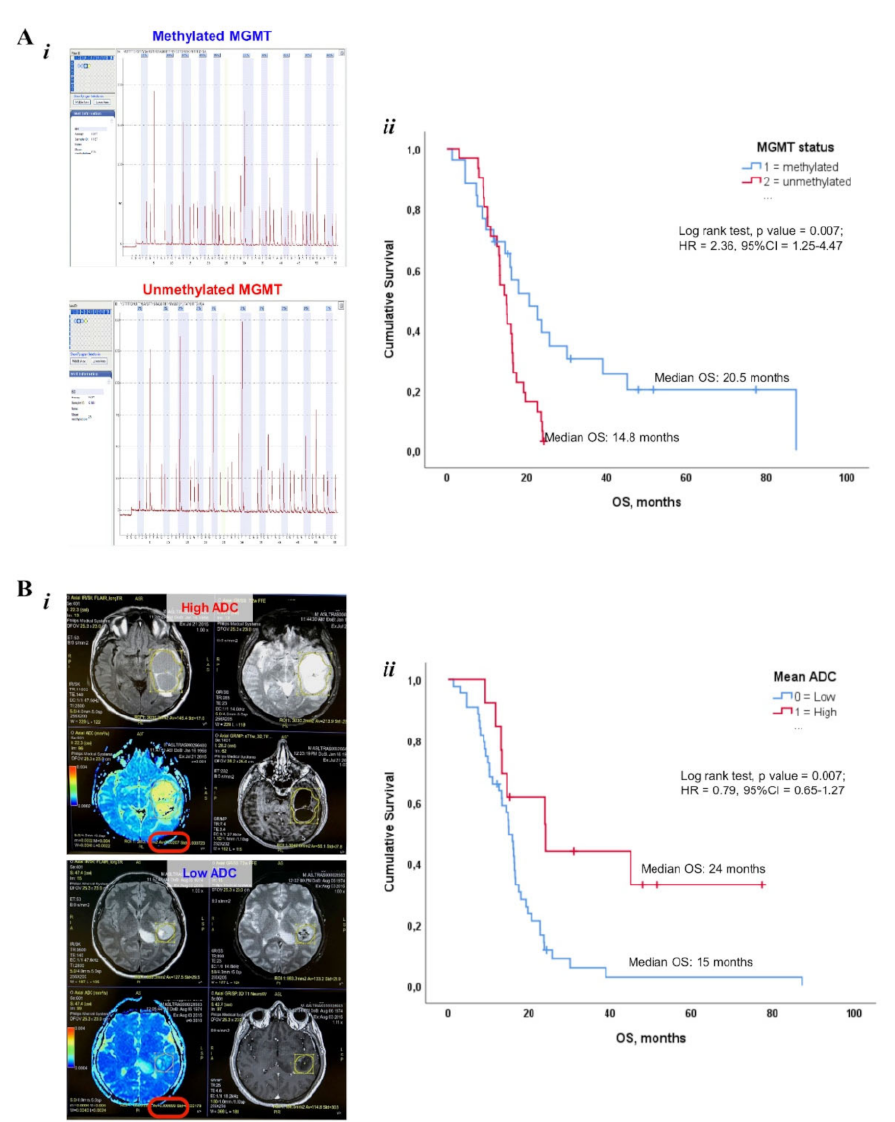
Figure 4. Impact of genetic and neuroradiologic features on survival outcome. ( A i ): Repre- sentative MGMT pyrosequencing of methylated (upper) and unmethylated (lower) GB samples. ( A ii ): Kaplan–Meier survival curves showing the impact of MGMT methylation status on OS. ( B i ): Representative MRI illustrating high (upper) and low (lower) apparent diffusion coefficient (ADC) values, which are encircled in red. ( B ii ): Kaplan–Meier survival curves documenting the impact of MRI-based Mean ADC on